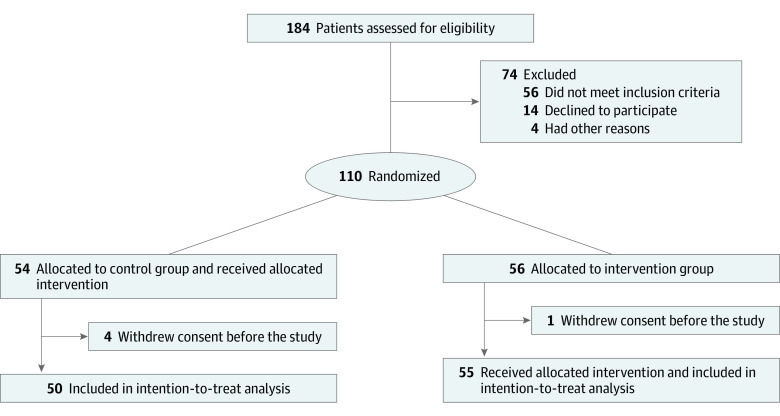
Study Flow Diagram